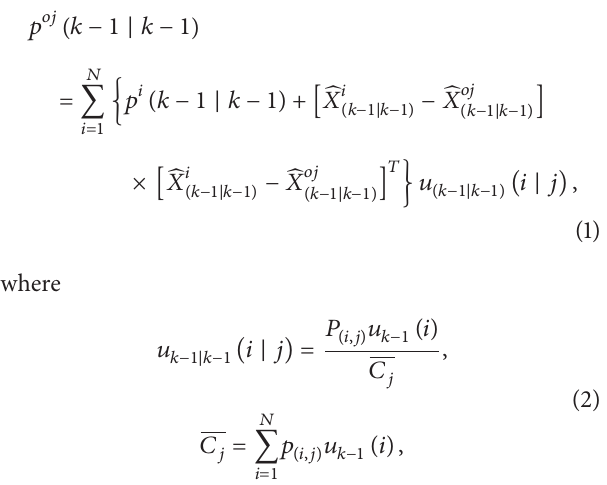
Figure 3: The SFF algorithm